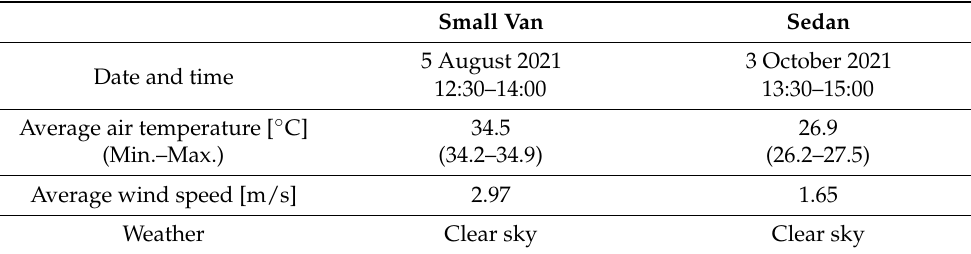
Figure 9. VIPV modules and sensors on the vehicle roof: small van ( top ), sedan ( bottom ). Table 3. Weather conditions during the daytime experiments.